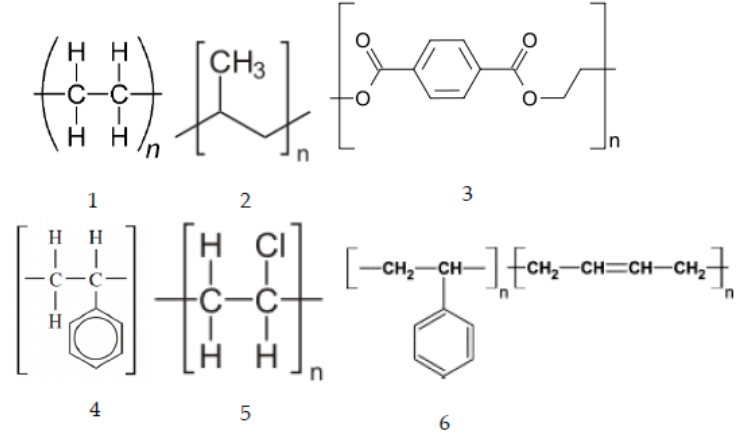
Figure 3. Thermoplastics used in iron ore reduction: ( 1 ) polyethylene, ( 2 ) polypropylene, ( 3 ) polyethylene terephthalate, ( 4 ) polystyrene, ( 5 ) polyvinyl chloride and ( 6 ) styrene-butadiene rubber (SBR).